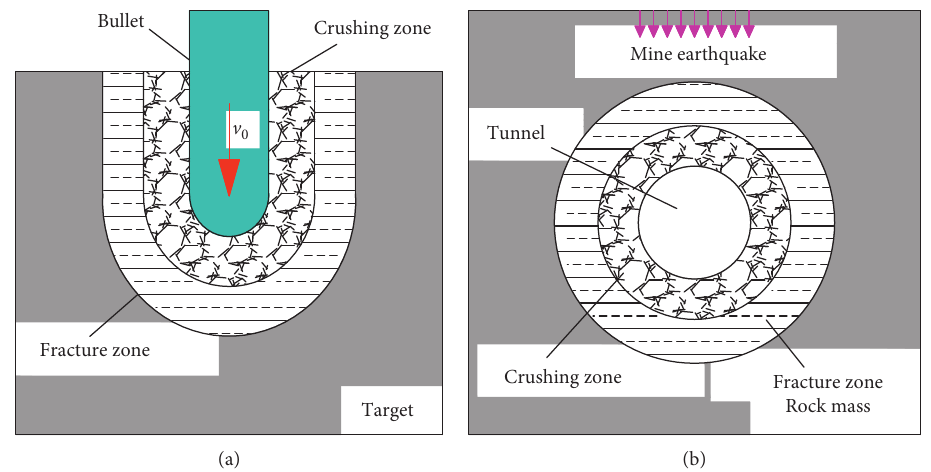
Figure 4: Analogy analysis chart. (a) Bullet hitting projectile target; (b) rockburst triggered by mine earthquake.